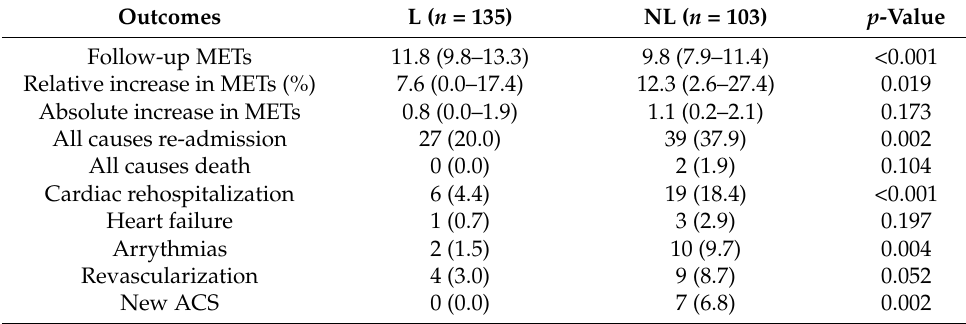
Table 2. Outcomes according to the low and no-low